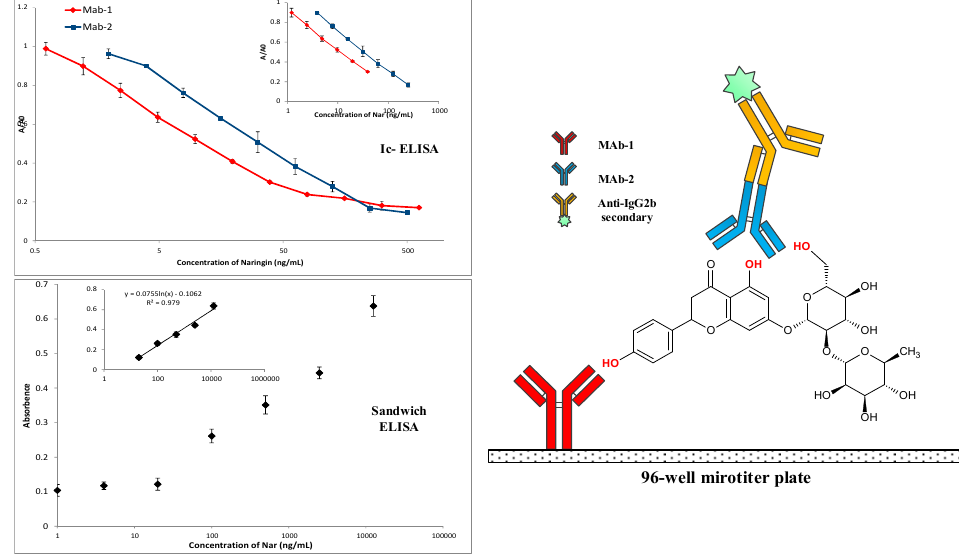
Figure 2. A true sandwich Enzyme-Linked Immunosorbent Assay (ELISA) for naringin and the comparison with ELISA [89]. Reprinted with permission from Huihua Qu et al. (2015), Copyright 2015 Analytica Chimica Acta.